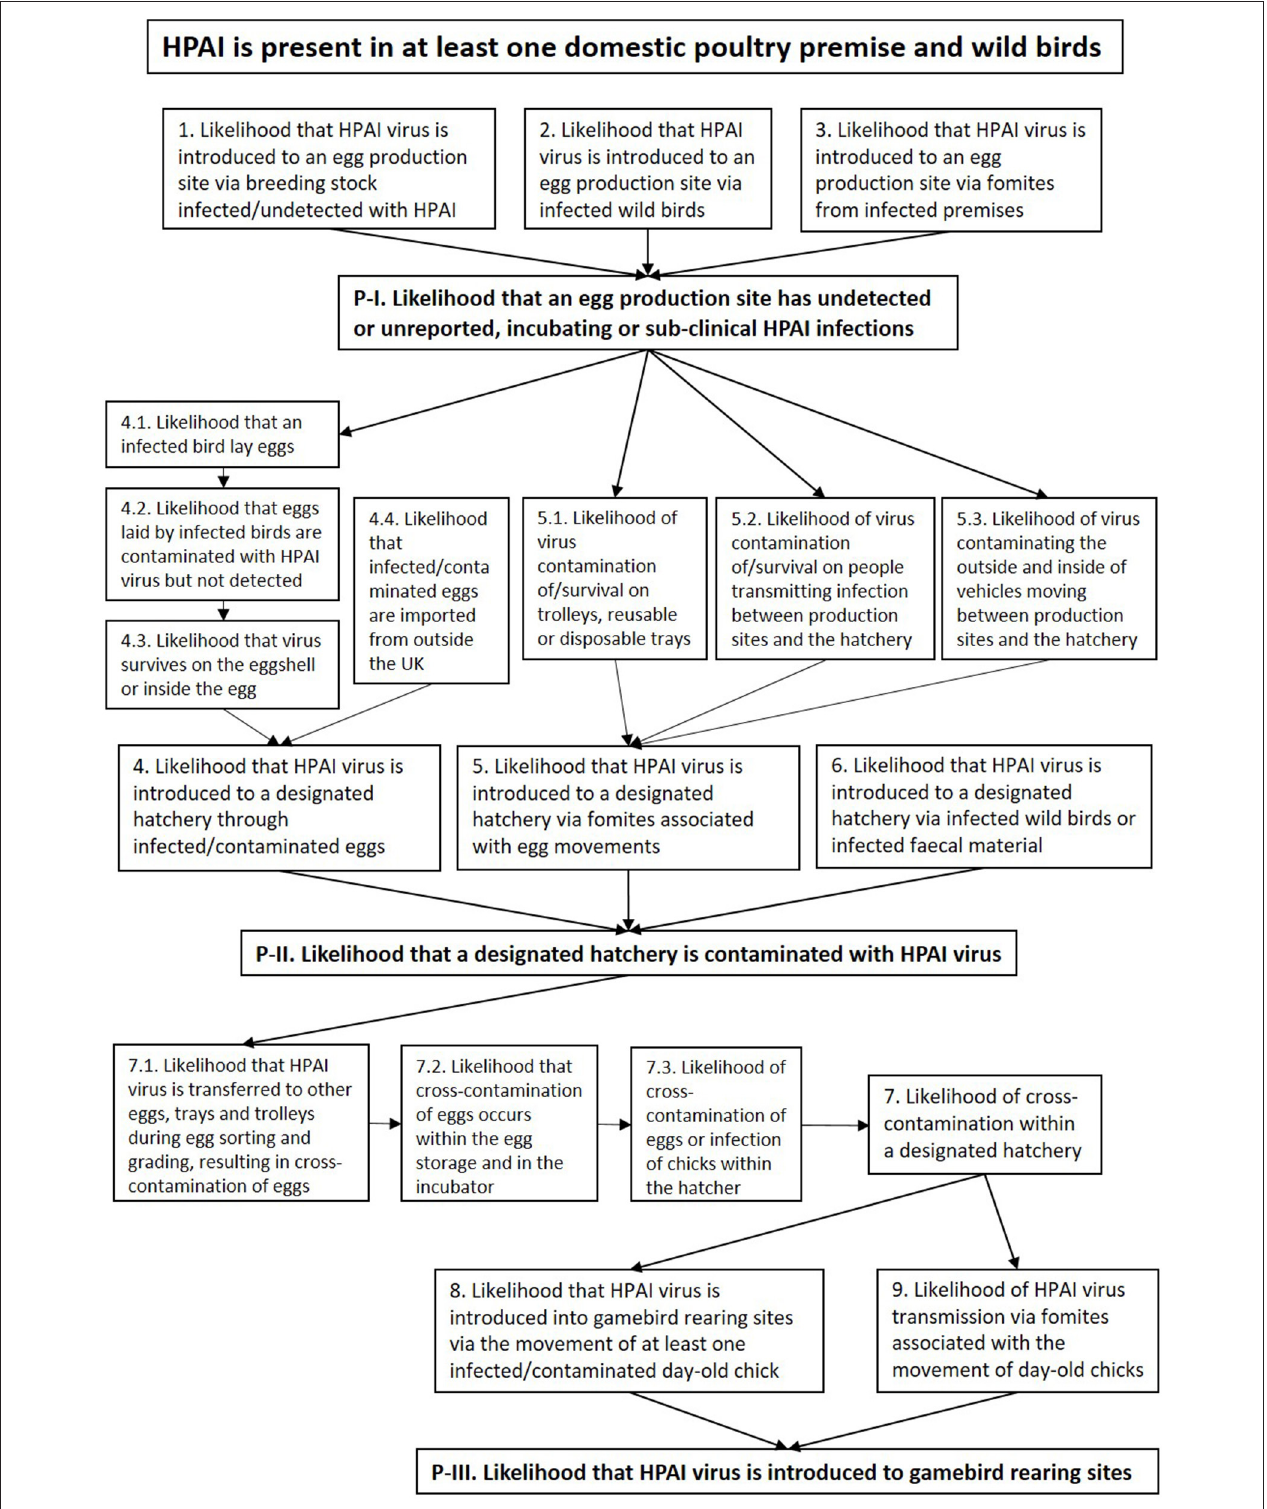
FIGURE 2 | Summary of risk pathways, illustrating the steps of the exposure of HPAIV to susceptible birds and products at different gamebird production sites. P-I, P-II, and P-III indicate three pathways that are identified as enabling the virus to be introduced to a designated hatchery and ultimately spreading the virus to gamebird rearing sites through the movement of hatching eggs and day-old chicks. Number 1–9 indicate sub-pathways, with the numbers 4, 5, and 7 including further paths contributing to each of the sub-pathways.